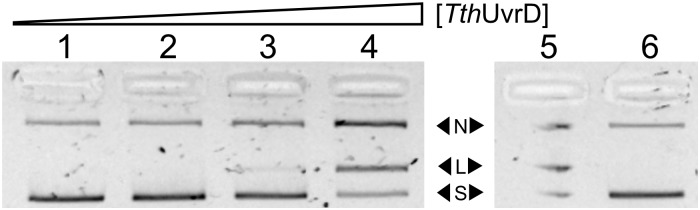
Effect of TthUvrD on TtAgo activity in vitro.Addition of TthUvrD improves TtAgo activity on dsDNA pUC19 plasmid substrate cut with guides pUC19-1 and pUC19-2 (Supporting information S1 Table). Reactions were supplemented with 1 mM ATP and carried out at 73 °C for 4 hr. Lanes 1–4) 10, 25, 50, and 100 ng of helicase, respectively; 5) pUC19 controls: nicked (N) with Nt.BspQI, linearized (L) with SspI, and supercoiled (S); 6) no helicase control—some plasmid relaxation occurs during prolonged incubation at high temperatures.